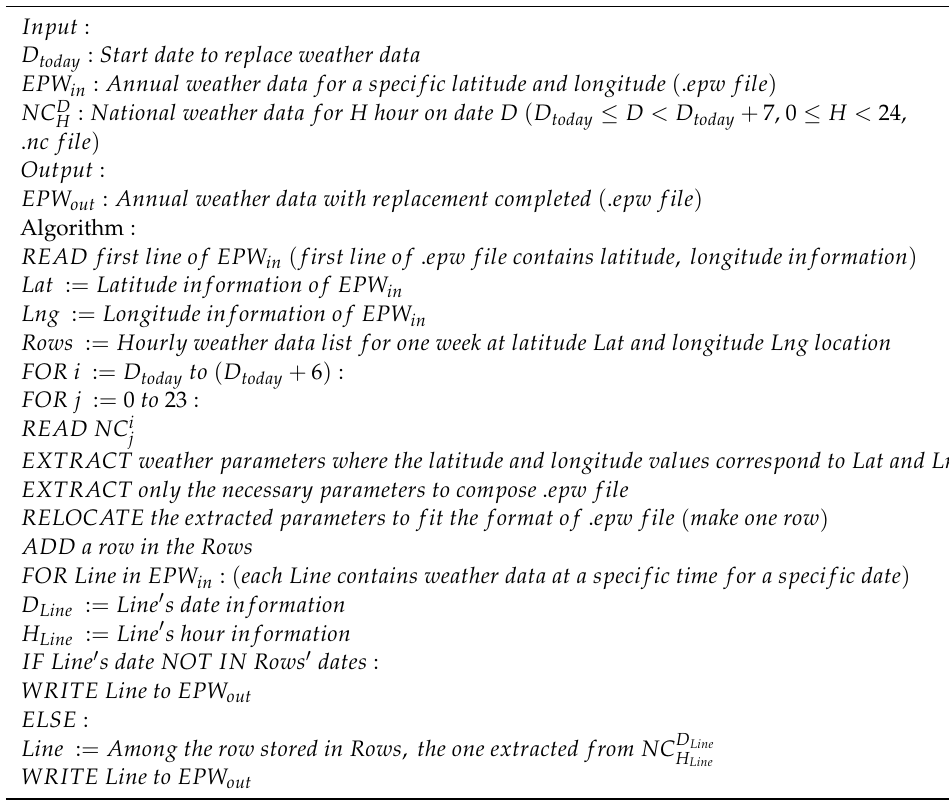
Algorithm 1. Pseudocode for merged data and converted LAMP